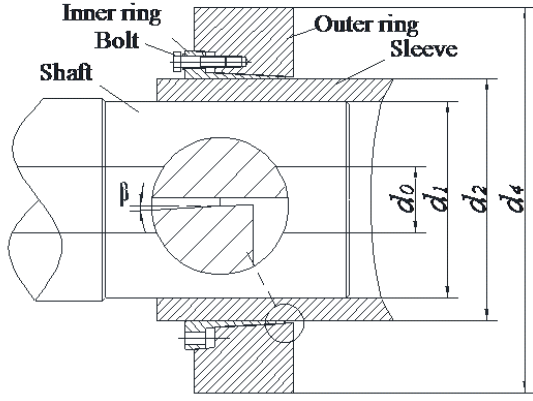
Figure 1. Schematic diagram of the turbine shrink disk.